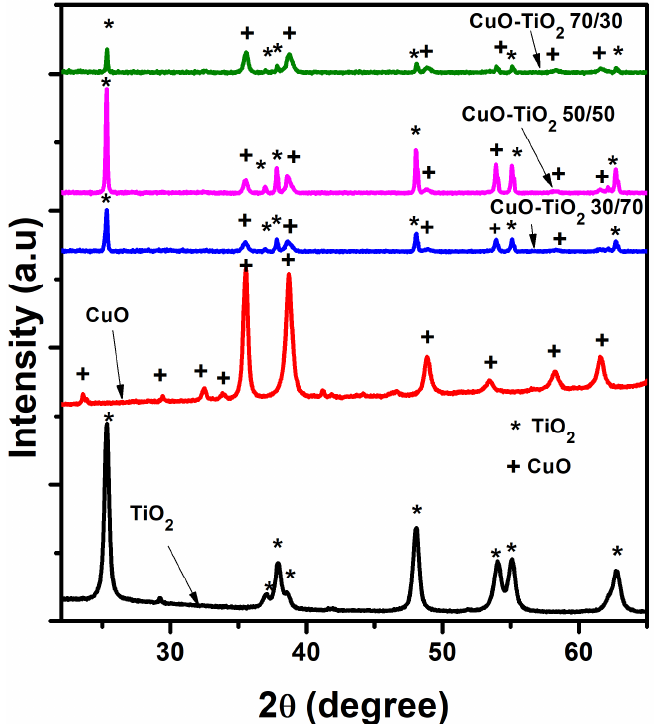
Figure 3. TiO 2 , CuO, and CuO ‐ TiO 2 (30/70, 50/50 and 70/30) XRD patterns.